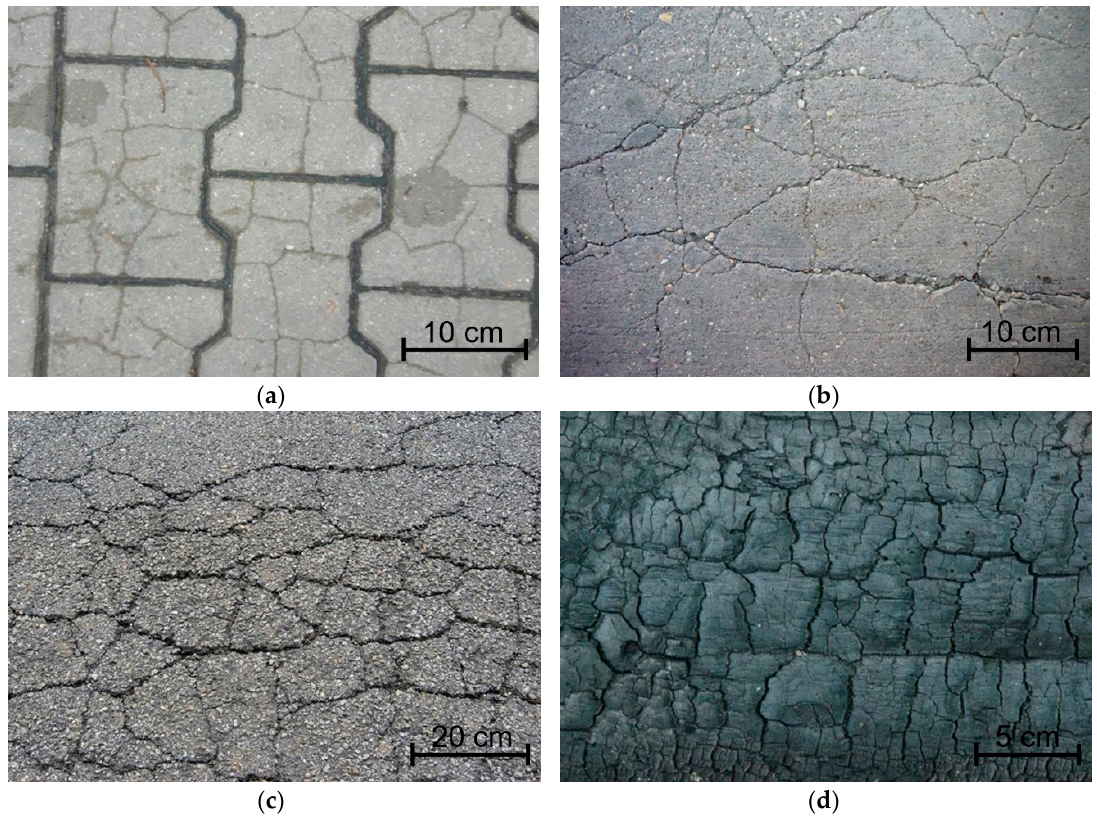
Figure 1. Cracking patterns visible on different materials: ( a ) concrete pavement stone; ( b ) concrete floor [19]; ( c ) asphalt surface [20]; ( d ) burnt wood [21].